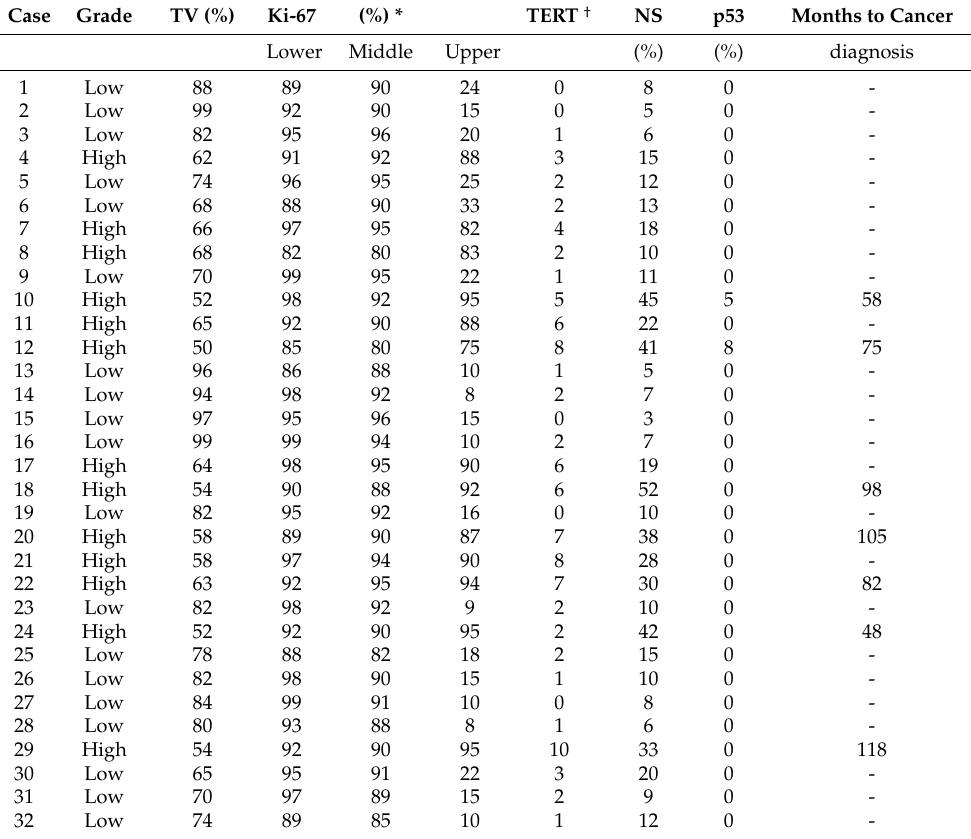
Table 3. Thirty two cases of DM out of 587 H. pylori -positive gastric mucosa